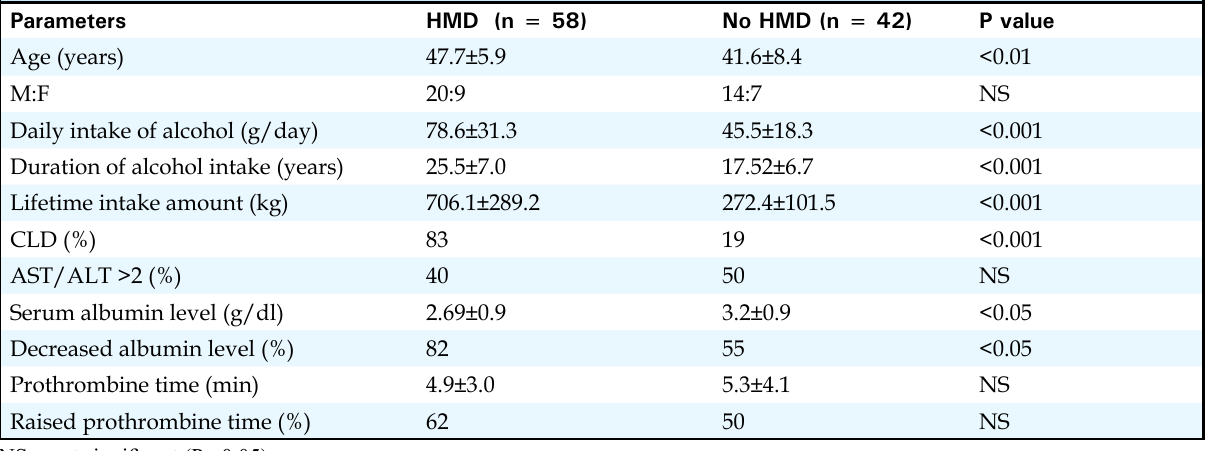
Table 3. Various parameters among subjects with HMD and without HMD.